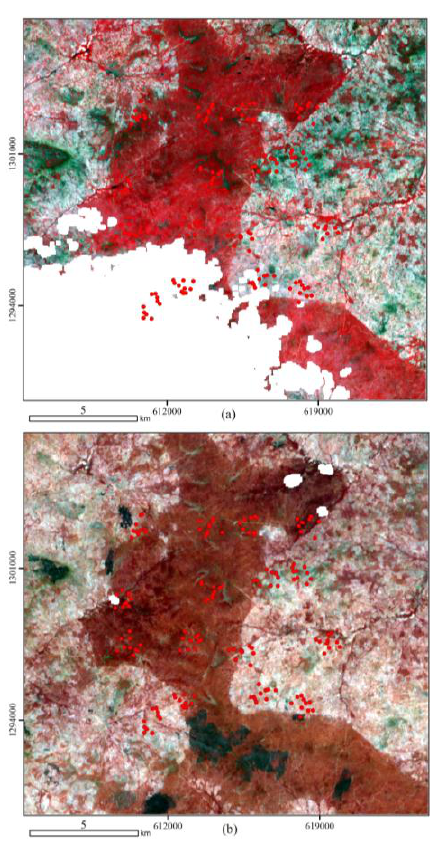
Figure 1. Examples of (a) wet and (b) dry season